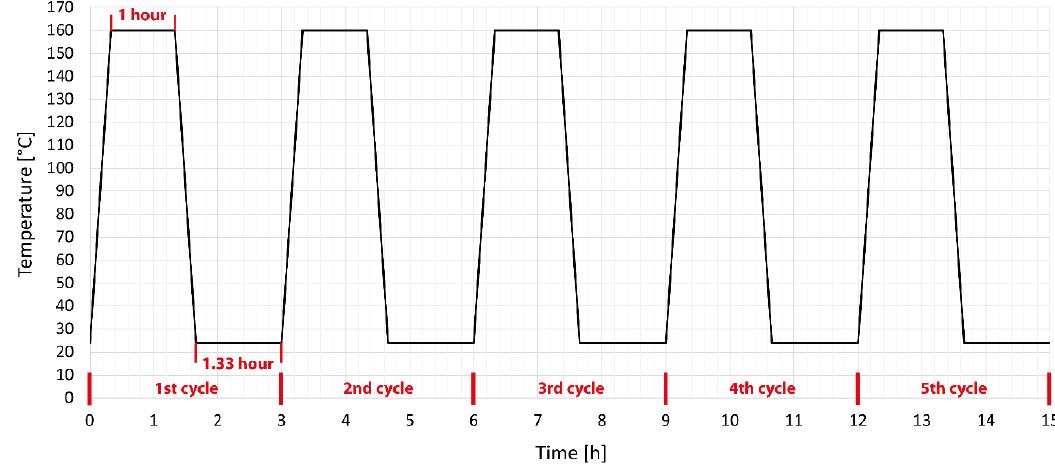
Figure 3. Setting temperature aging cycle of HDPE above the melting point [38].